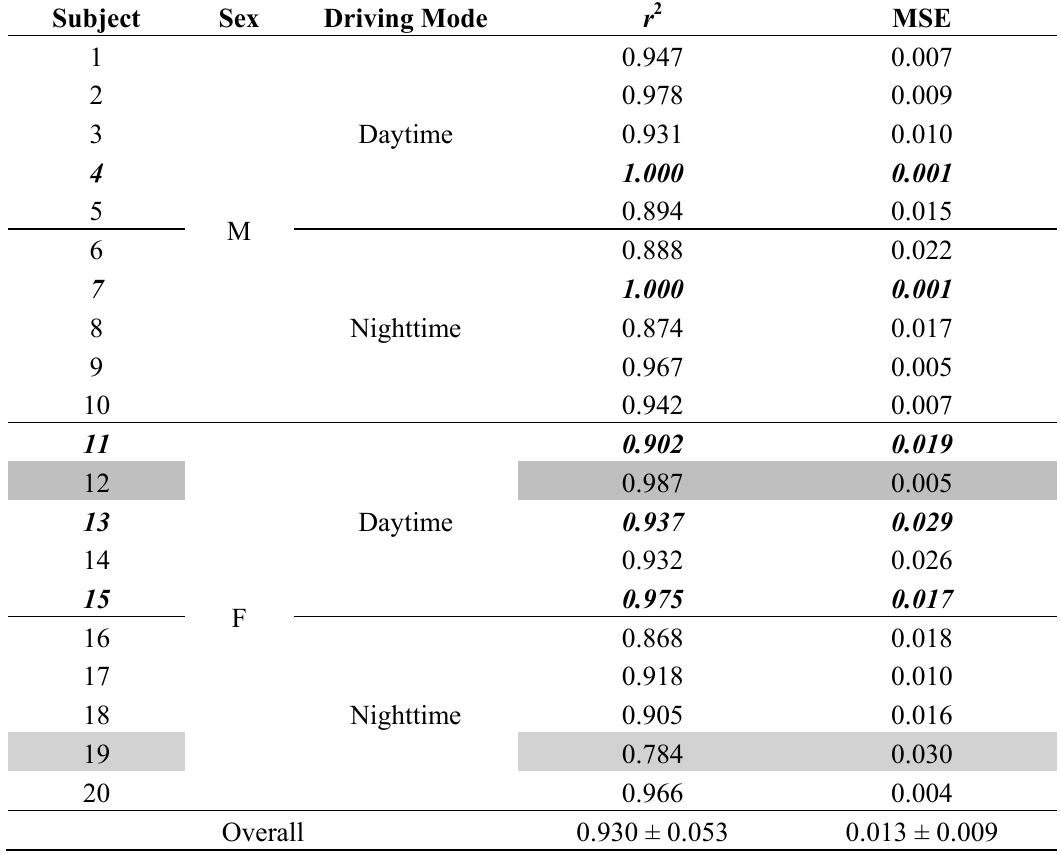
Table 6. The full ECD estimation results using optimized linear and non-linear